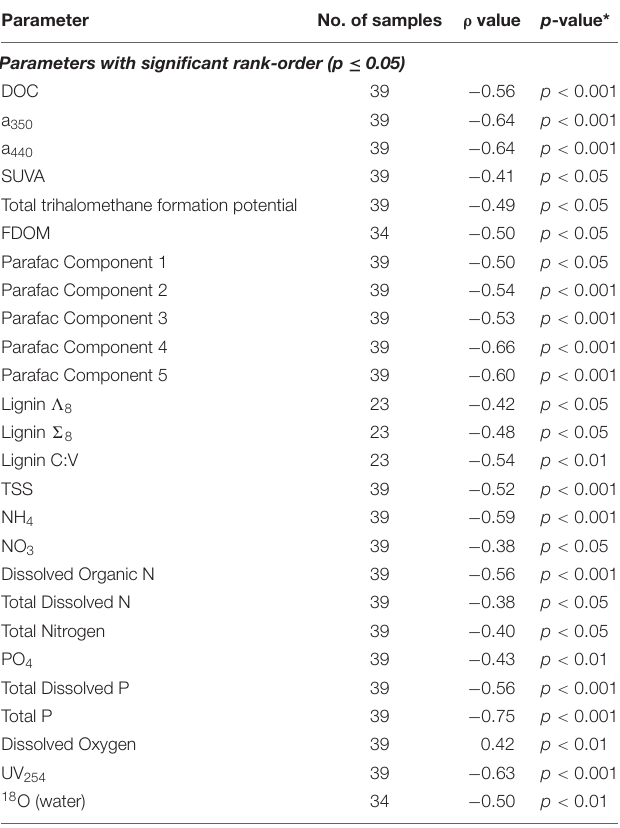
TABLE 4 | List of measured parameters showing statistically significant rank order correlation in the Willow Slough watershed. Parameter No. of samples ρ value p -value *